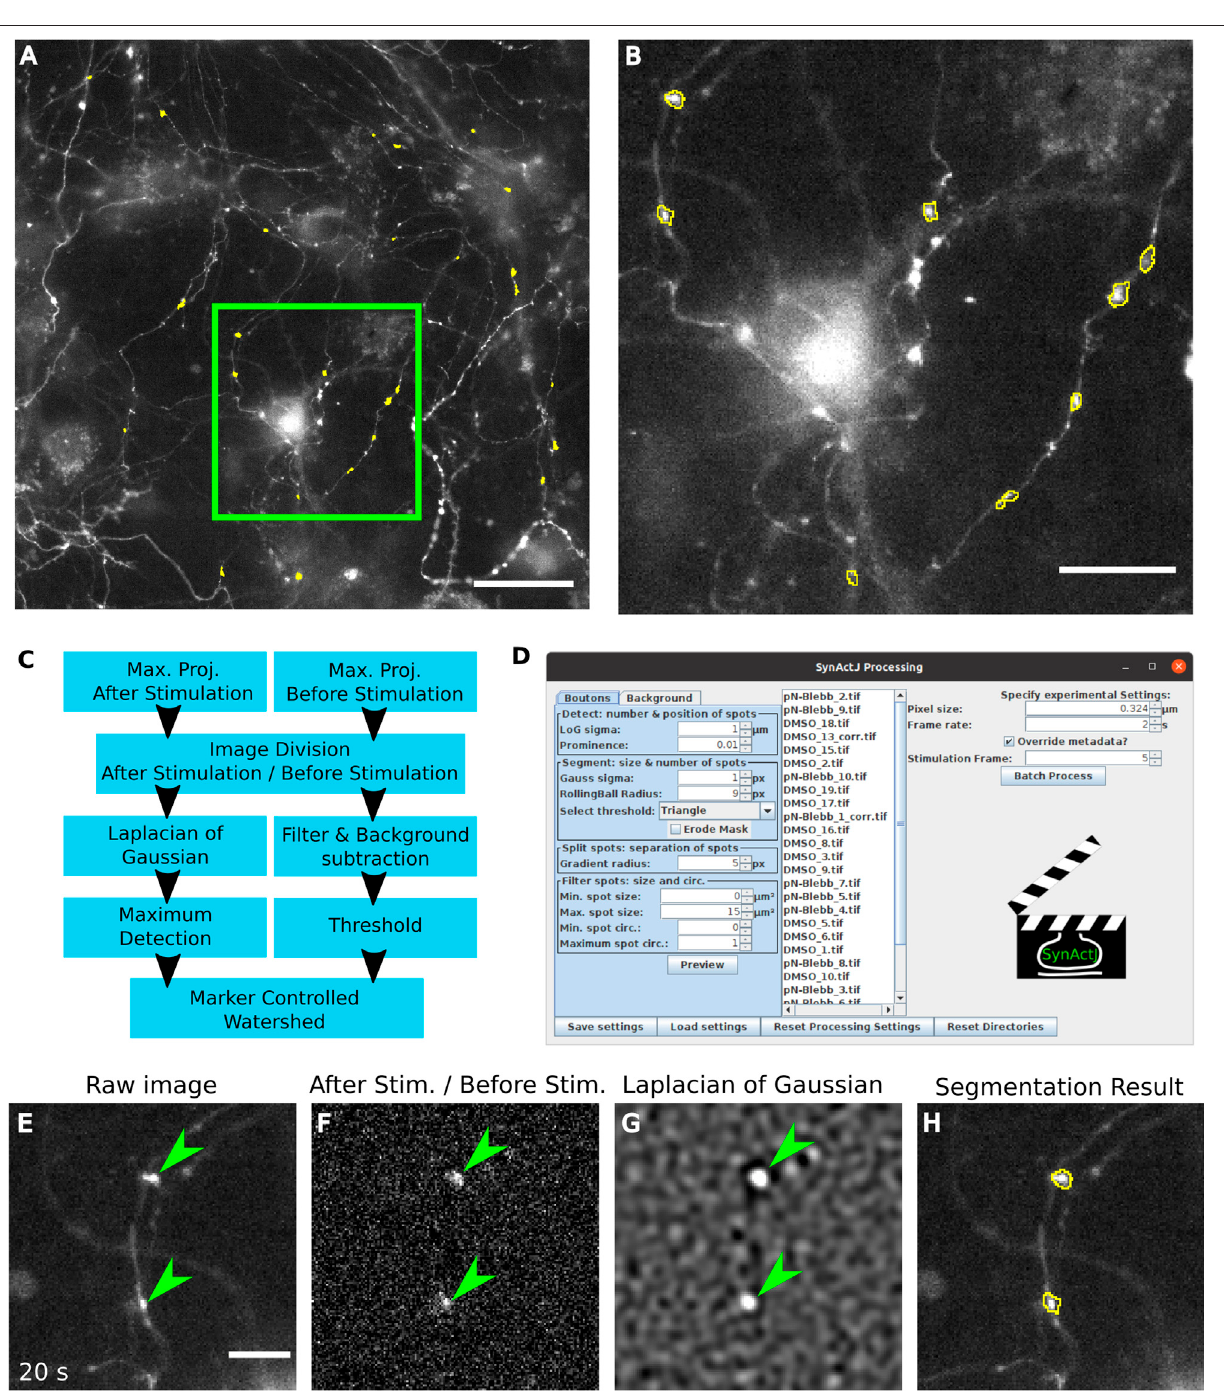
FIGURE2| Fast,automaticandeasy-to-useimageanalysisofsynapticactivityusingSynActJ. (A) HippocampalneuronalculturestransfectedwithSynaptophysin-pHluorin. [ (A,B) , yellow outlines] Structures showing a signal response upon stimulation, corresponding to active synaptic boutons are segmented with SynActJ. (C) Segmentation is achievedbydetectingblob-likestructuresthatdisplayanincreaseinsignalafterthestimulationframeandbyseparatingtouchingstructuresusingamarker-controlledwatershed. (D) The segmentation parameters can be adjusted and veri fi ed on the entire dataset using a GUI that allows testing each segmentation parameter easily, after which the work fl owcanbeexecuted inbatch.[ (E) ,arrowheads]Crop ofarawimageshowingSynaptophysin-pHluorinwithpeak fl uorescenceafterelectricalstimulation.[ (F) ,arrowheads] The increase in signal around the time point of stimulation is enhanced by dividing the maximum projection of time points after the stimulation by the time points before the stimulation.[ (G) ,arrowheads]Blob-likestructuresofaspeci fi csizeareenhancedusingaLoG fi lter].[ (H) ,yellowoutlines]Activeboutonsaresegmentedusinganintensitythreshold and touching objects split with a seeded watershed. Scale bars: 50 µm (A) , 20 µm (B) and 10 µm (E – H) .